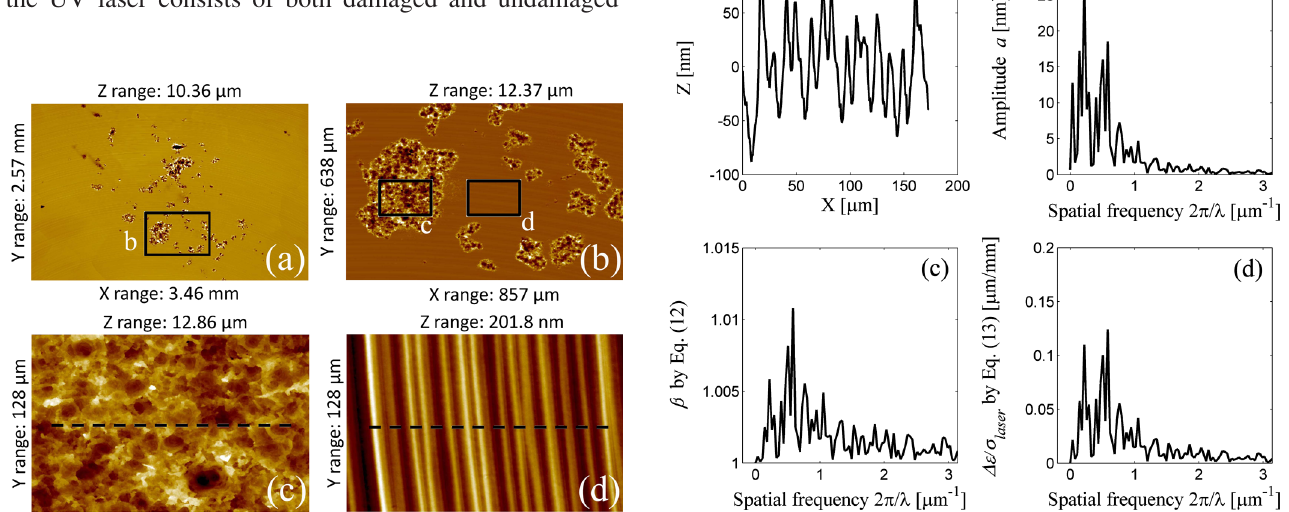
FIG. 9. Surface roughness analysis of the dashed line in Fig. 7(d): (a) surface perturbation profile, (b) spatial frequency spectrum, (c) field enhancement factor, and (d) roughness emit- tance growth at 50 MV = m